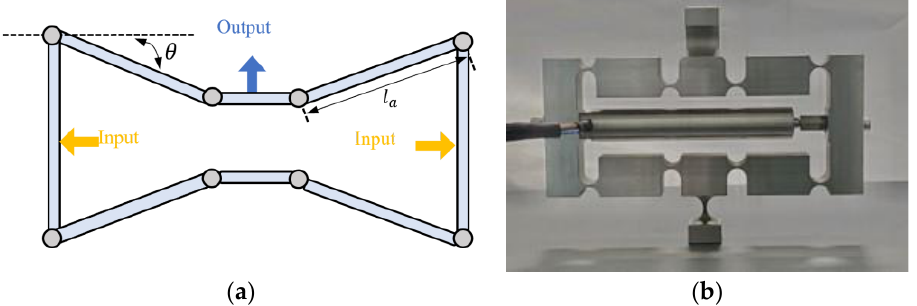
Figure 3. ( a ) Deformation of flexible amplification mechanism. ( b ) Flexible amplification mechanism with piezoelectric actuator.